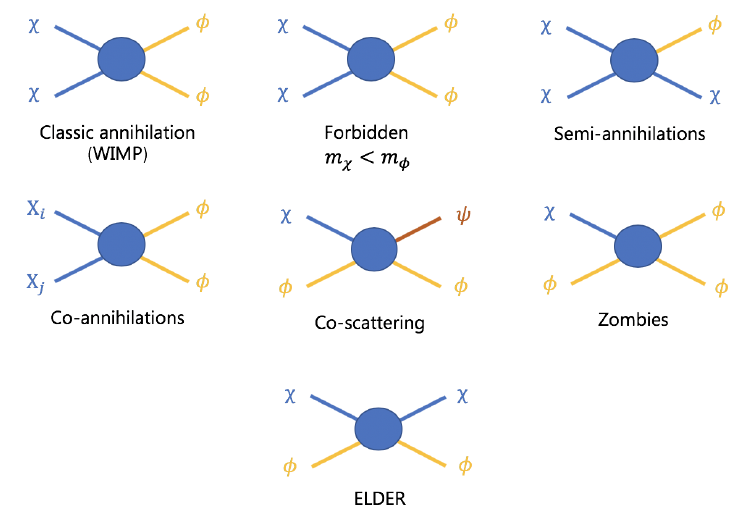
Figure 1: Some examples of the 2 → 2 zoo: WIMP annihilations, forbidden chan- nels [ 2,3 ] , semi-annihilations [ 4 ] , co-annihilations [ 2 ] , co-scattering [ 5 ] , zombies [ 6 ] and ELDERs [ 7 ] . Time flows from left to